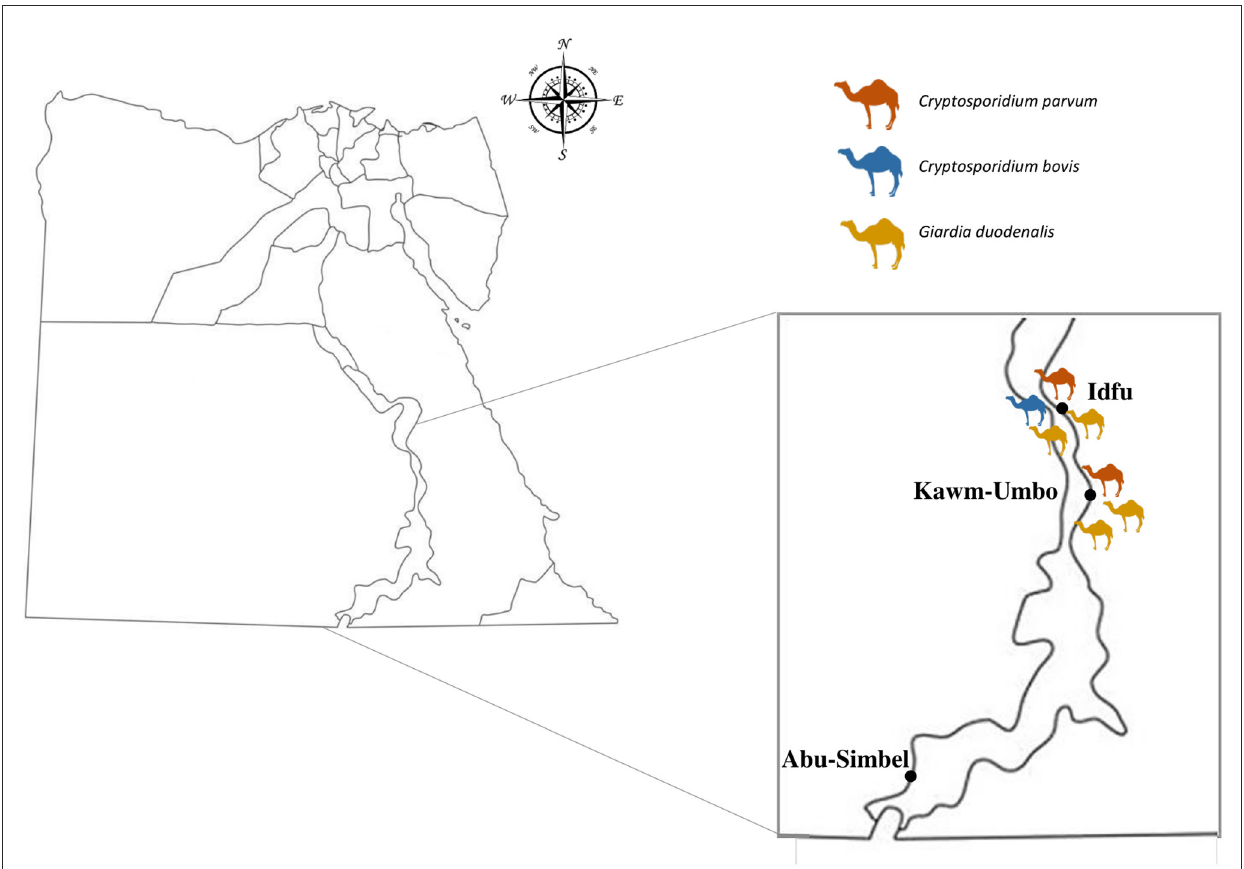
FIGURE1 Map of Egypt showing the location of the sampling areas and the distribution of dromedary camels positive to Cryptosporidium spp. and G. duodenalis